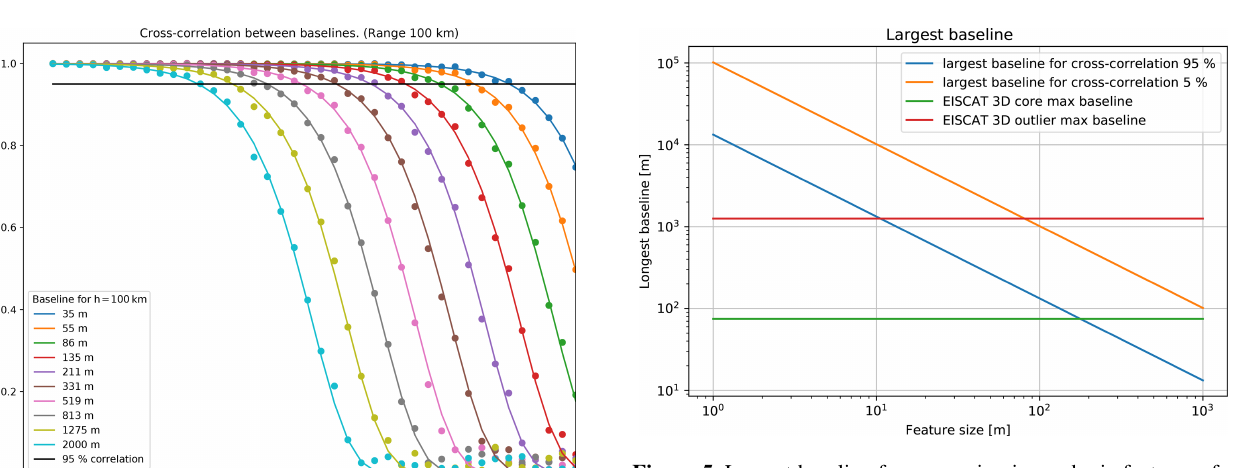
Figure 5. Largest baseline for recovering ionospheric features of a certain size. Measurements in the area under the blue line have high ( > 95%) correlation, while over the orange line the correlation is lower than 5%. Longer baselines cannot be used to resolve features of this size.